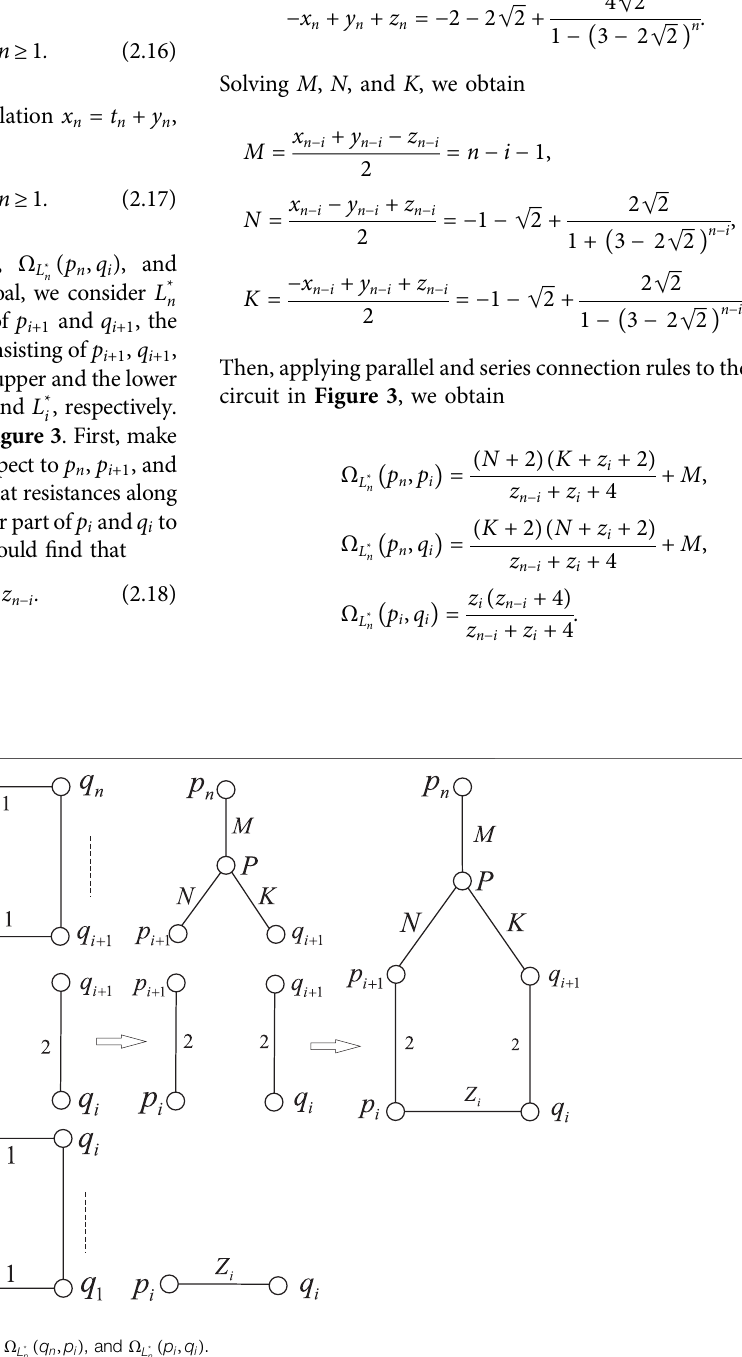
Frontiers in Physics |